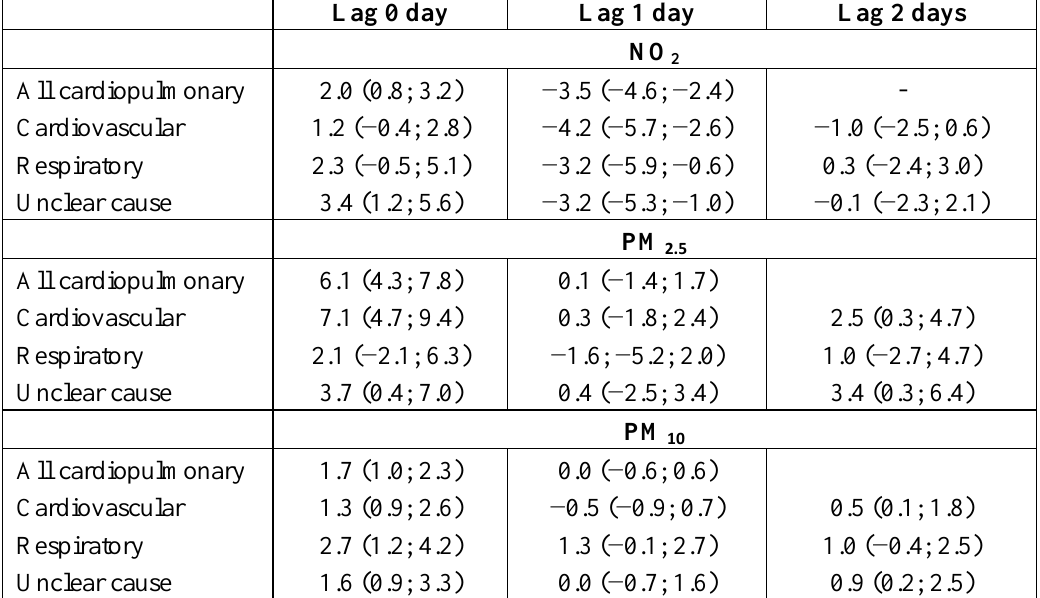
Table 2. Per cent increase in ambulance calls (with 95% confidence intervals) related to a 10 µg/m³ increase in the respective pollutant measure. Linz